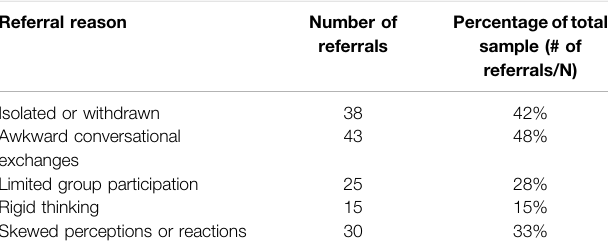
TABLE1| ReasonforTeacherReferral.Teachersmarkedwhichreason(s)applied for the students they reported (N (cid:1) 90). Referral reason Number of